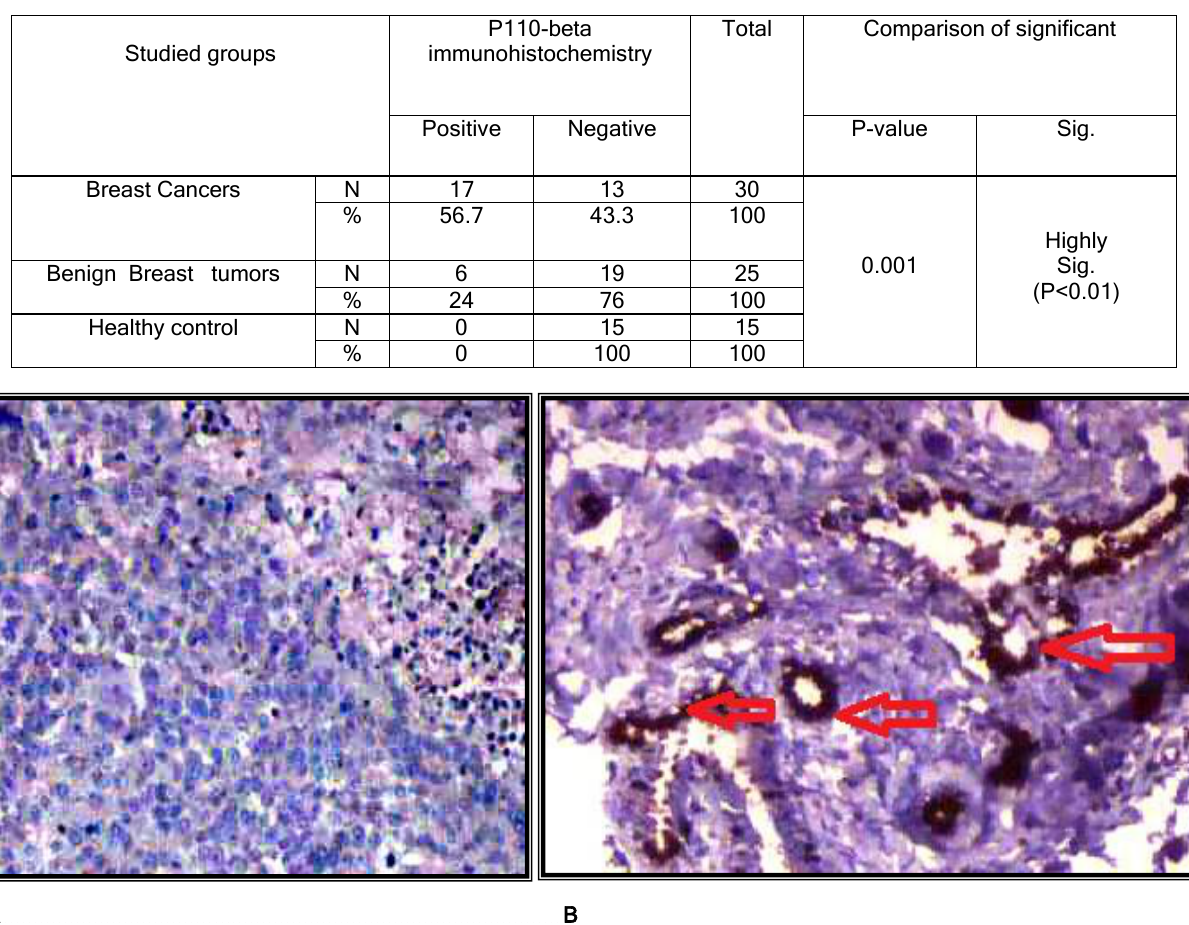
FIGURE 1: Immunohistochemical reactions (IHC) for detection of P110-beta usingspecific primary antibodies for P110- beta and biotinylated -labeled anti- P110-beta ;Stained with HRP/DAB (brown) and counter stained by hematoxyline (Blue).A. Invasive breast ductal carcinoma with negative P110-beta –IHC reaction(40X). B. Invasive breast cancer with positive P110-beta –IHC reaction that revealed high score and strong signal intensity